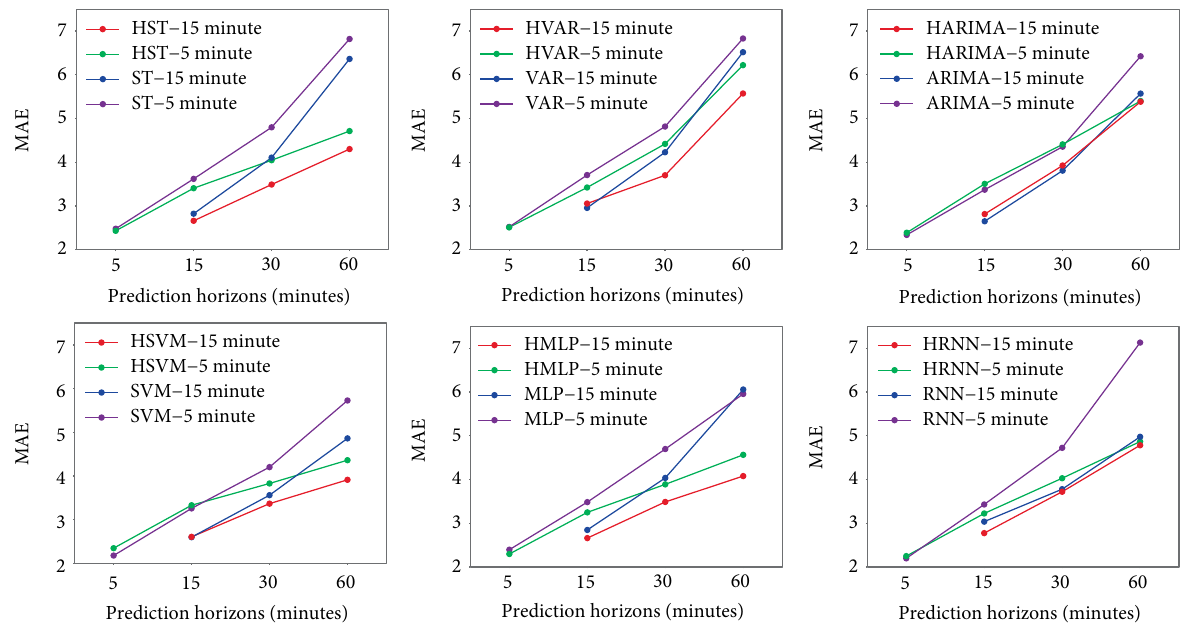
Figure 9: The MAE values of models for different horizons and aggregation levels in off-peak hours on station C.